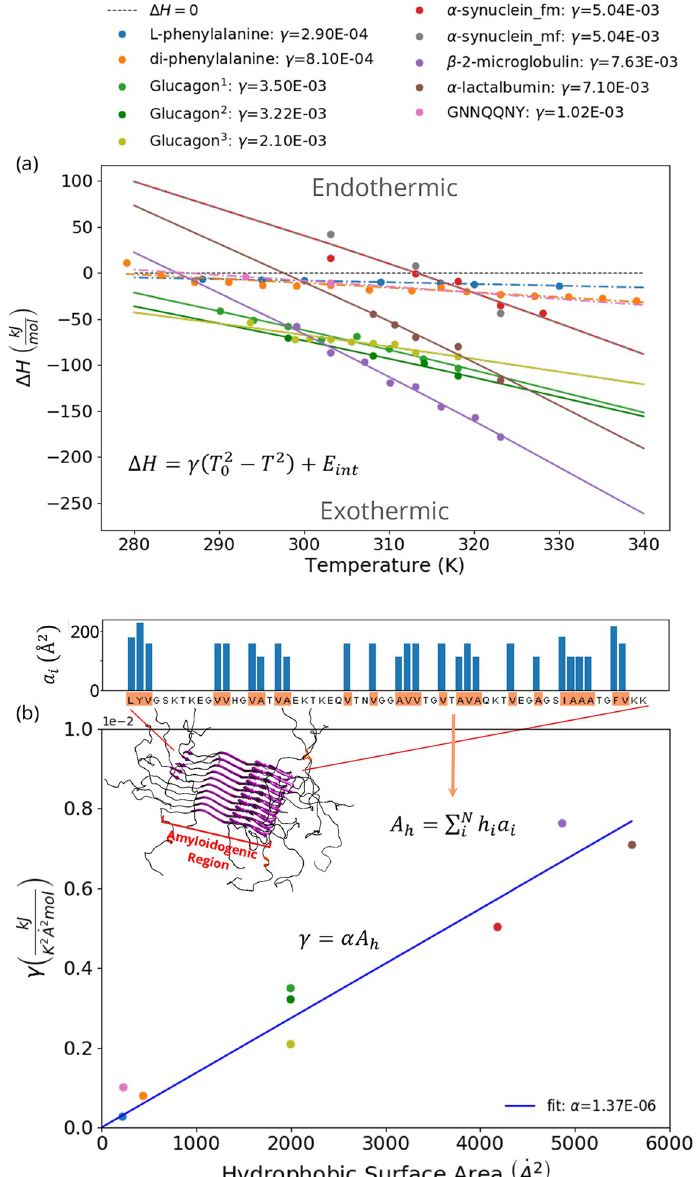
Fig 5. Enthalpy of amyloid fibril elongation and peptide and amino acid crystallisation at different temperatures. The enthalpy of fibril elongation of α -lactalbumin, α -synuclein, glucagon and β -2-microglobulin [33] (solid lines), as well as the enthalpies of crystallisation of L-phenylalanine [60], diphenylalanine [61] and of GNNQQNY in water (dashed lines) are shown as a function of temperature. For α -synuclein, ITC experiments were conducted in two set- ups: fibrils titrated into monomer solution (red symbols) and monomers titrated into fibril solution (grey symbols). See the Materials and methods and S2 Methods for experimental details. (A) Eq 11 was fitted through each of the curves to estimate the strength of the hydrophobic effect ( γ ) in kJ . (B) Relationship between the fitted values of γ and K 2 mol the total hydrophobic surface area of the proteins ( A h ). 1 10 mM HCl, 1 mM Na 2 SO 4 , data from [34]. 2 10 mM HCl, 1 mM Na 2 SO 4 . 3 10 mM HCl, 30 mM